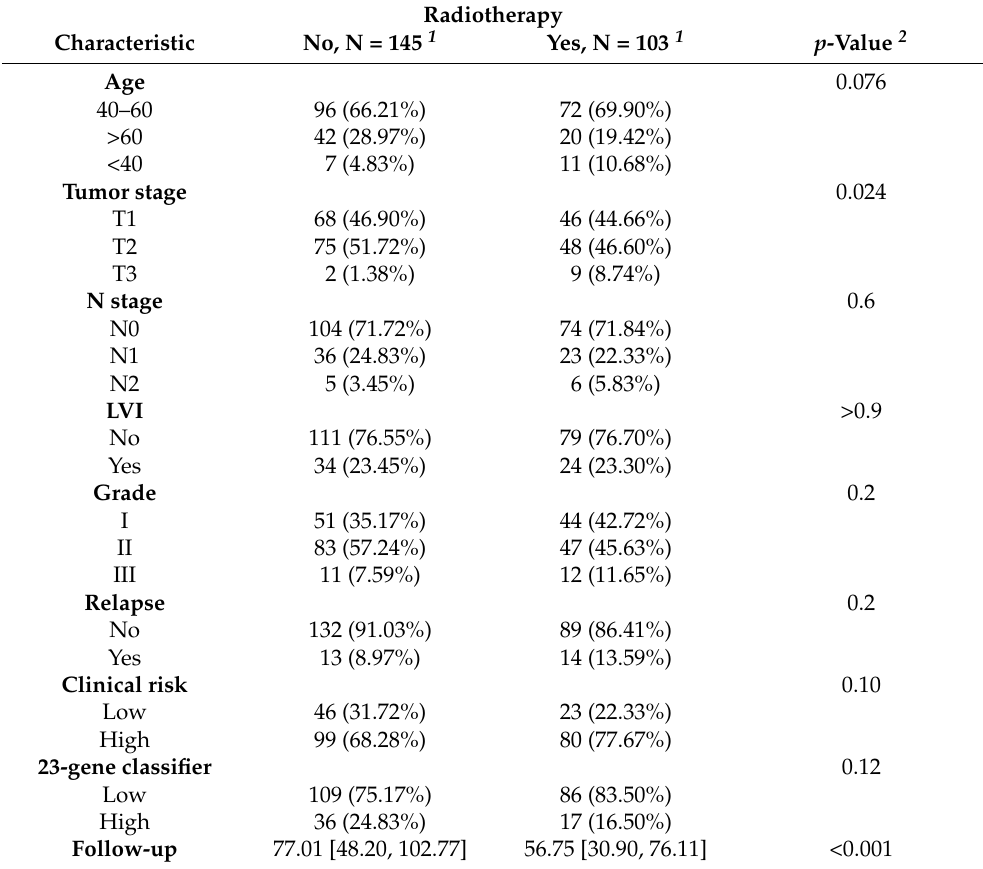
Table 3. Basic clinical characteristics among patients with/without radiotherapy.